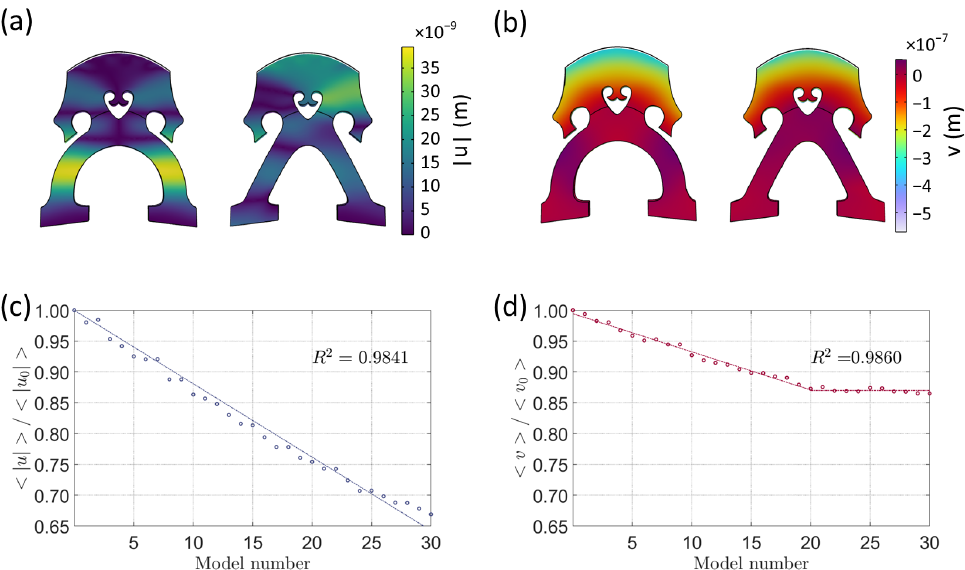
Figure 3. Displacement fields on the bridge under load. ( a ) Magnitude of the displacement along the x direction. ( b ) Displacement along the y direction. ( c ) Spatial average of the displacement along the x direction normalized for the Normal Model, as a function of the model number. The equation of the linear fitting curve is f ( m ) = − 0.0119 m + 1. ( d ) Spatial average of the displacement along the y direction normalized for the Normal Model, as a function of the model number. The equation of the piecewise linear fitting curve is f ( m ) = − 0.0062 m + 0.9946 for m ≤ 20, f ( m ) = 0.8699 for m > 20. The R-squared refers to the first portion of the fit, as the constant value in the second portion is the